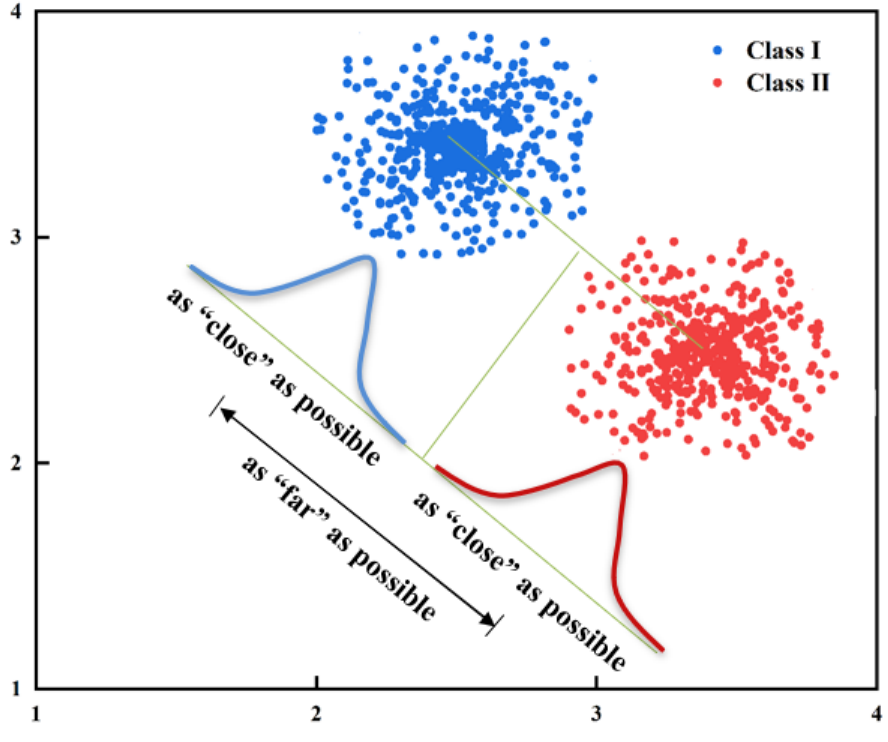
Figure 6. LDA classification model diagram.